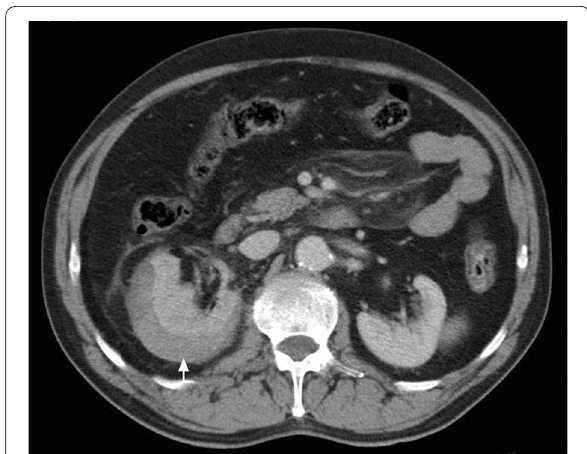
Fig. 2 CT scan of the abdomen. Sixty-one-year-old male 24 h after ESLW presenting with acute right lumbar pain. Contrast CT showing a subcapsular collection in the right kidney (arrow), compatible with subcapsular renal hematoma, without other renal or abdominal